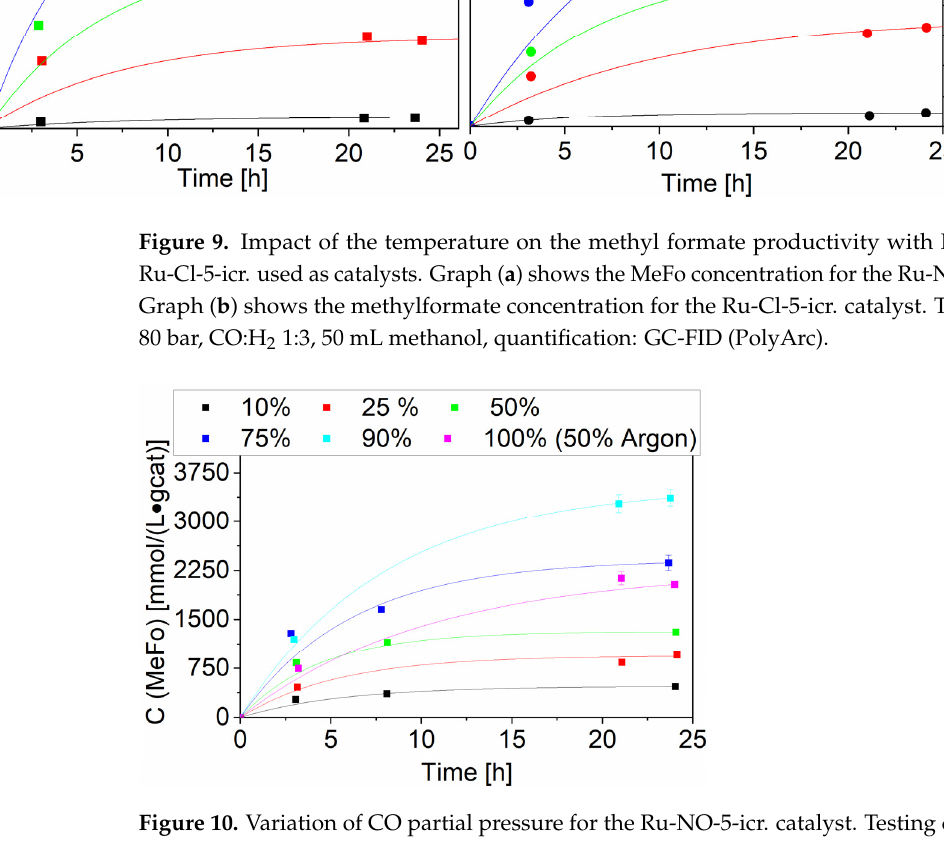
Figure 11. Comparison of temperature variation for RuNi-NO-ir. (Graph ( a )) and RuNi-Cl-ir. (Graph ( b )) catalysts. Solid lines (filled squares and circles) show concentration of methylformate. Black lines show the concentrations generated at 90 °C, red lines show the concentrations generated at 110 °C and green lines show the concentrations generated at 130 °C. Testing conditions: 80 bar, CO:H 2 1:3, 50 mL methanol, quantification: GC-FID (PolyArc). The RuNi-Cl-ir. catalyst as observed at 90 °C catalysed the direct formation of DMM from methanol and synthesis gas. This exothermic reaction is in an equilibrium state after 24 h of operation [5,6]. Therefore, the increase of the temperature leads to a decrease in equilibrium concentration of DMM as observed in Figure 12. A continuous removal of water from the reaction mixture could increase the equilibrium concentration of DMM. This has been achieved by Tanksale et al. in a CO 2 hydrogenation reaction directly to DMM by using molecular sieves [5].